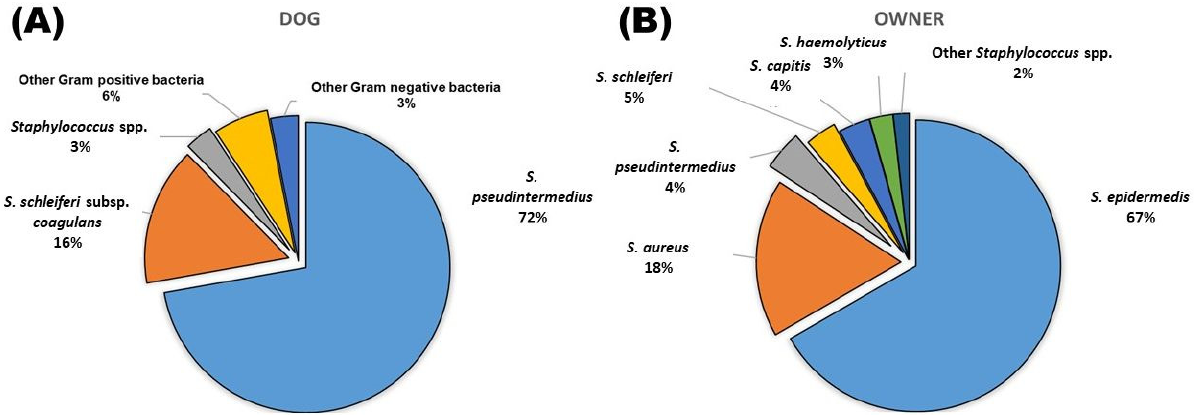
Figure 1. Bacterial isolation and identification from dogs with superficial pyoderma ( A ) and their owner ( B ).